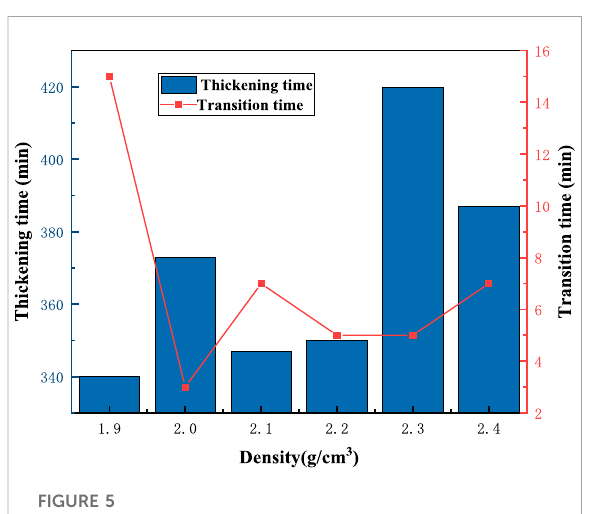
FIGURE 5 Thickening properties of multicomponent composite anti- corrosion cement slurry system under different densities. FIGURE 6